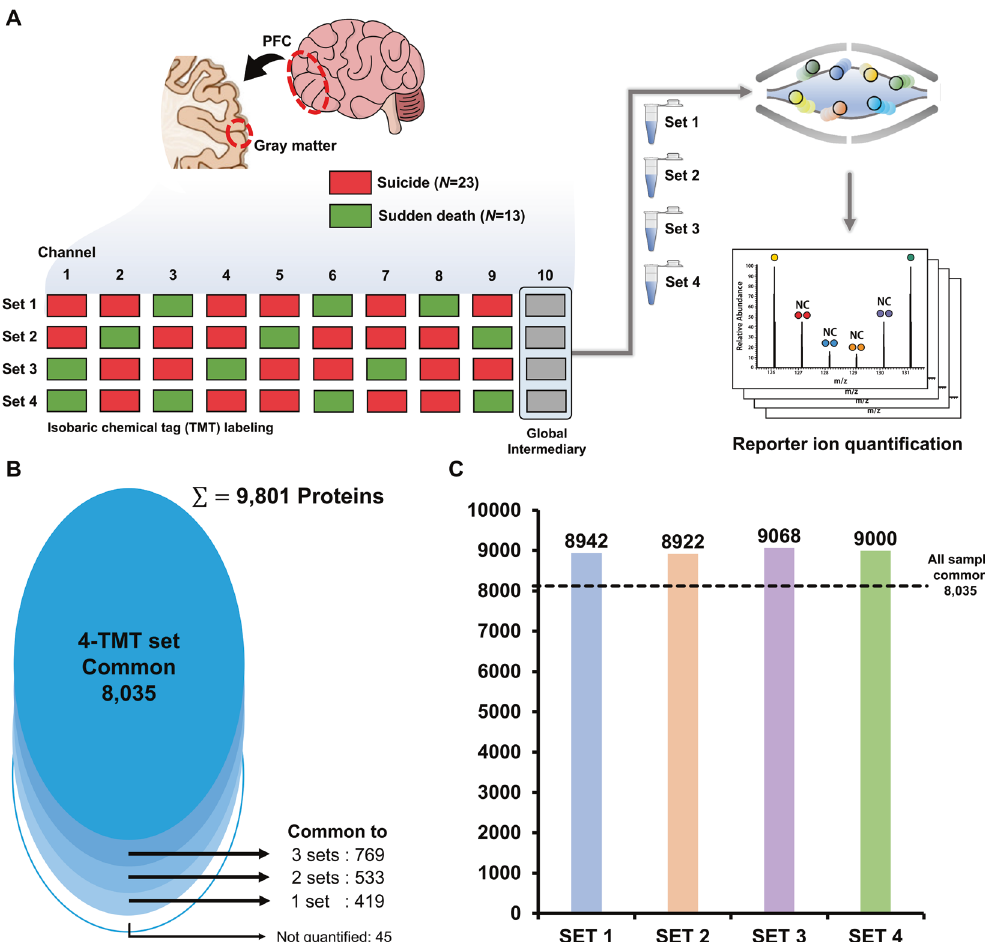
Fig. 1 Detailed experimental work fl ow. A Distribution of the 36 samples to four tandem mass tag (TMT) experimental sets. Each experimental set comprised nine samples and one common pooled sample. B A total of 8035 proteins were quanti fi ed in all four experimental sets. C About 9000 proteins were identi fi ed similarly in all four experimental